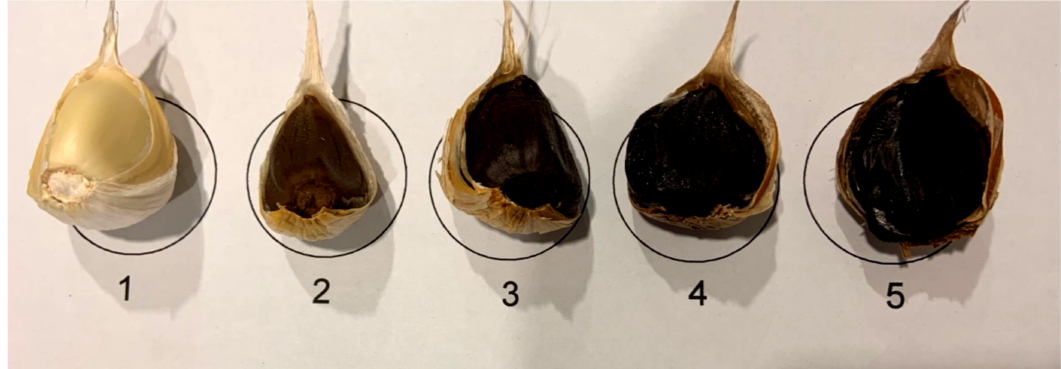
Figure 1. Garlic and black garlic samples used in this investigation. Number 1 was not heated; whereas 2 was heated for 7 days, 3 for 14 days, 4 for 21 days, and 5 for 28 days. The diameter of the circle is 4.0